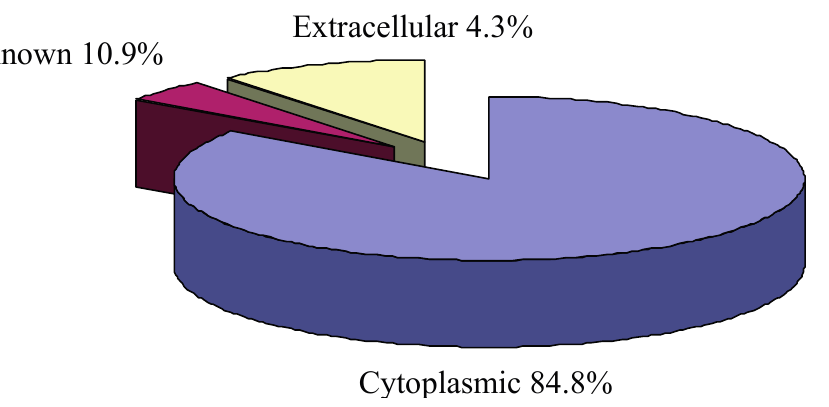
Bacillus amyloliquefaciens FMB38 predicted by the PSORTb